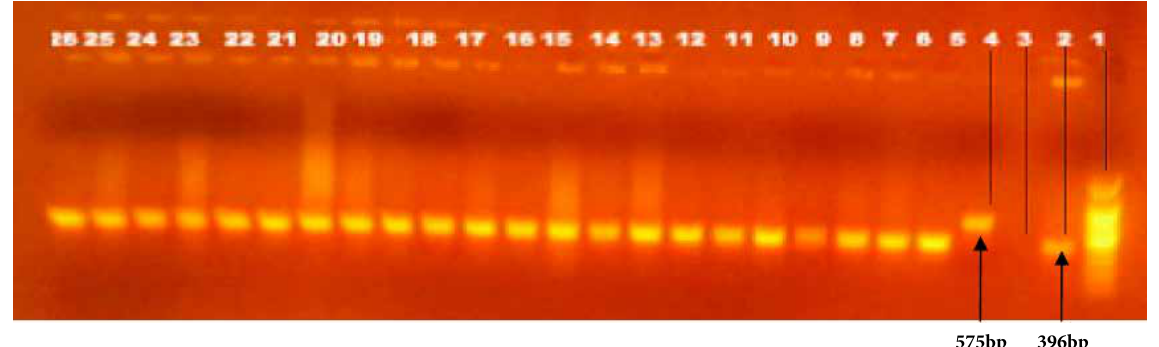
Figure 1: Electrophoretic separation of PCR products by RD9 deletion typing. The figure represents only for 22 mycobacteria isolates from sputum and FNA human samples: Lane 1 DNA ladder, 2 M. tuberculosis control (396 base pair), 3 molecular grade water (negative control), 4 M. bovis control (575 bp), lane 5_26 are culture isolates of M. tuberculosis from human tuberculosis patients designated with their sample